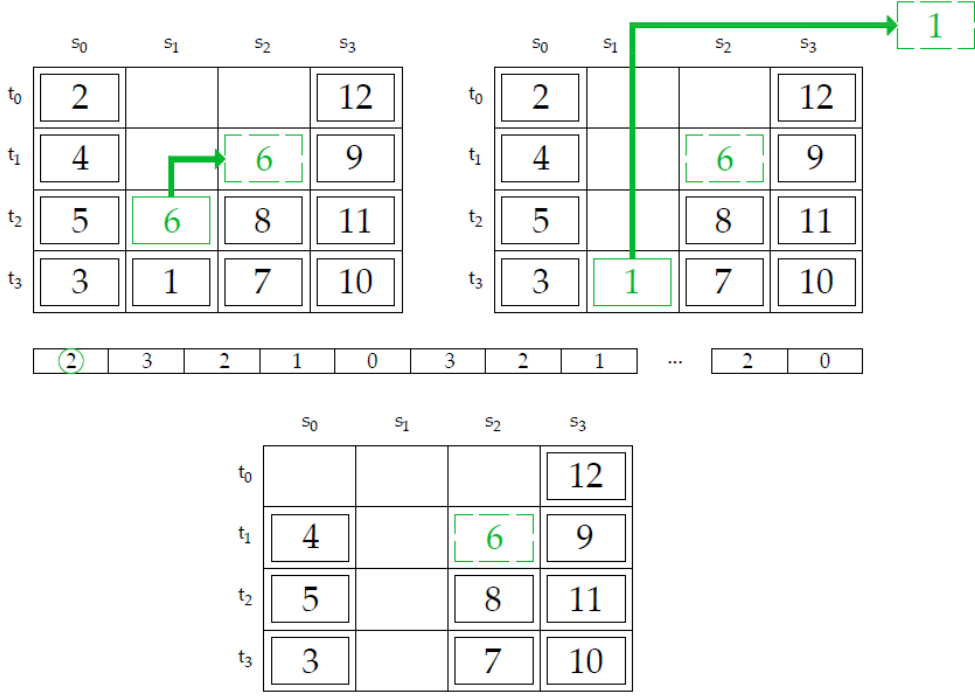
Figure 5. The relocation of container 6 and the retrieval of container 1.